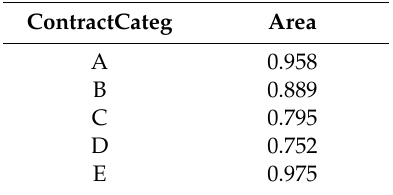
Figure 5. Lift chart for ContractCateg variable. Table 5 indicates the area under each curve for the dependent variable ContractCateg. Table 5. Area under the curve for ContractCateg .